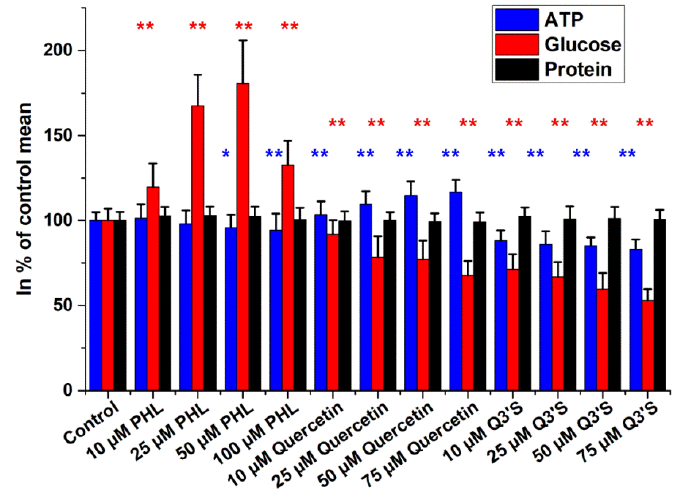
Figure 4. Intracellular glucose, ATP, and total protein levels of HepG2 cells after 4 h treatment with inhibitors of glucose transporters (GLUTs). Data are expressed as % of control. Bars represent mean ± SD of six independent experiments (* p < 0.05, ** p < 0.01 compared with controls).